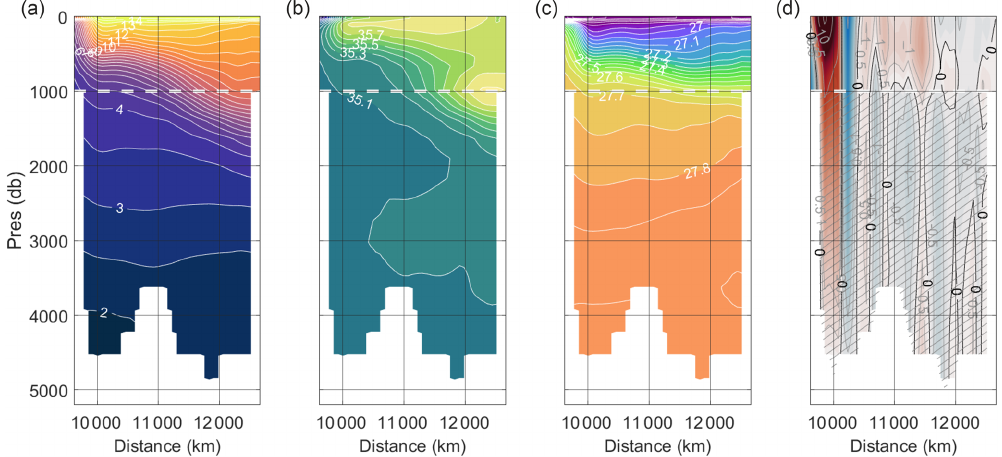
Figure 4. Zonal (47 ◦ N) section constructed from EN4 data and shown to full depth for (a) conservative temperature ( ◦ C), (b) absolute salinity (gkg − 1 ) , (c) density ( σ 0 , kgm − 3 ), and (d) geostrophic velocities into the SPG perpendicular to contour (cms − 1 ) . Annual means are shown. The sub-1000m region in (d) delineated by cross-hatching is subject to a correction velocity (see Sect. S5 for details). The 1000m vertical threshold for transport calculations is delineated by the dashed white